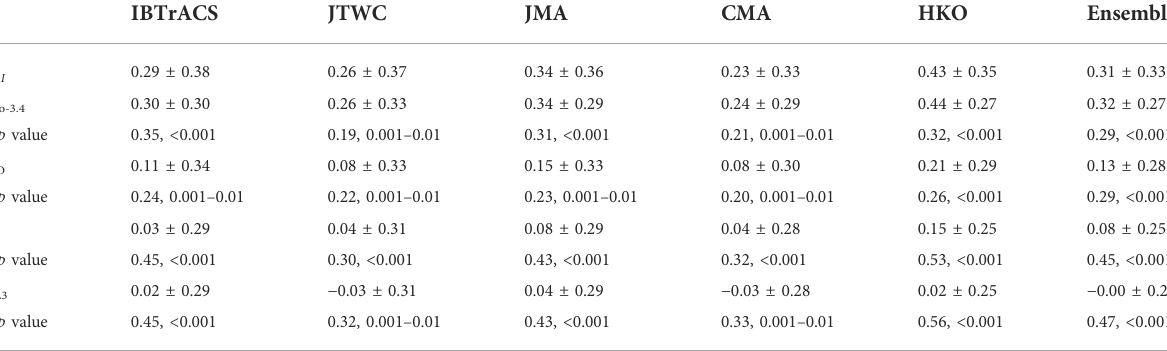
TABLE 1 Linear trends of annual-mean latitude of LMI and its regression residuals for best-track data from various sources. The WNP TC track migration rates and 95% con fi dence intervals (latitude decade − 1 ) of annual-mean φ LMI , the residuals of the regression of φ LMI onto the JASON- mean Niño-3.4, PDO, and TPI indices (i.e., ε Niño-3.4 , ε PDO , and ε TPI ) respectively and the residuals of the trivariate regression of φ LMI onto the three indices (i.e., ε ALL3 ) for the various best-track data sources. For the single-variate and trivariate regressions, the variance explained R 2 and the p value are also shown. IBTrACS JTWC